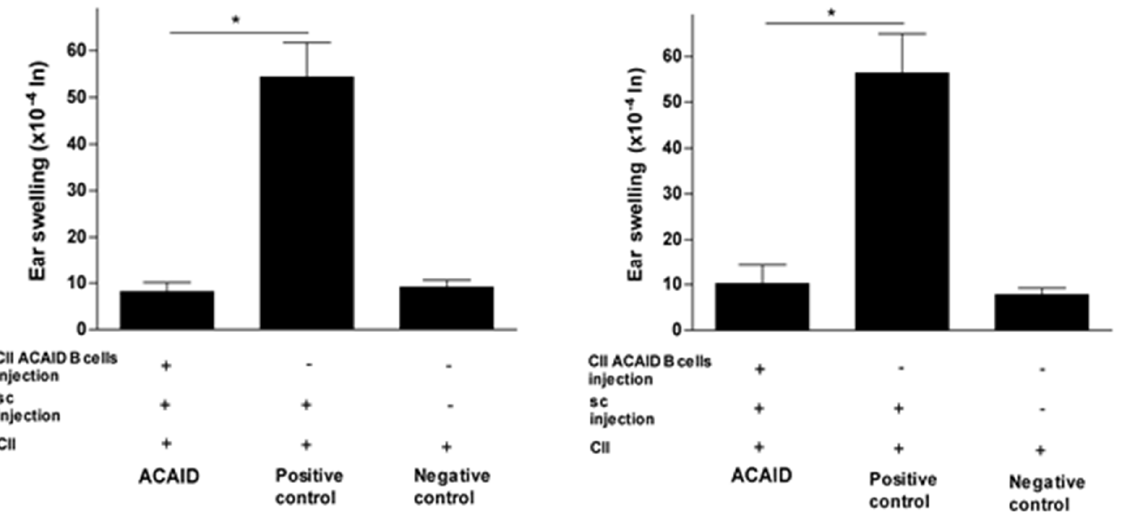
Figure 3. In vitro generated CII-specific ACAID B cells inhibited CII-induced DTH responses in DBA/1 mice. The in vitro generation of CII-specific ACAID B cells and the DTH assay were described in the Materials and Methods section. CII-specific ACAID B cells were intravenously injected to induce ACAID followed by subcutaneous immunization with CII/CFA on day 7. On day 14, mice were challenged with CII (500 µg in 20 µL) intradermally in the left ear pinna, and 20 µL of acetic acid alone was injected into the right ear pinna as an internal control. ACAID induction was confirmed by suppression of ear-swelling responses 24 h (left panel) and 48 h (right panel). The positive control mice were subcutaneously immunized with CII/CFA on day 7 and with CII on day 14, whereas the negative control mice only received intradermal injection of CII on day 14. * p < 0.05 were considered to be statistically significant.